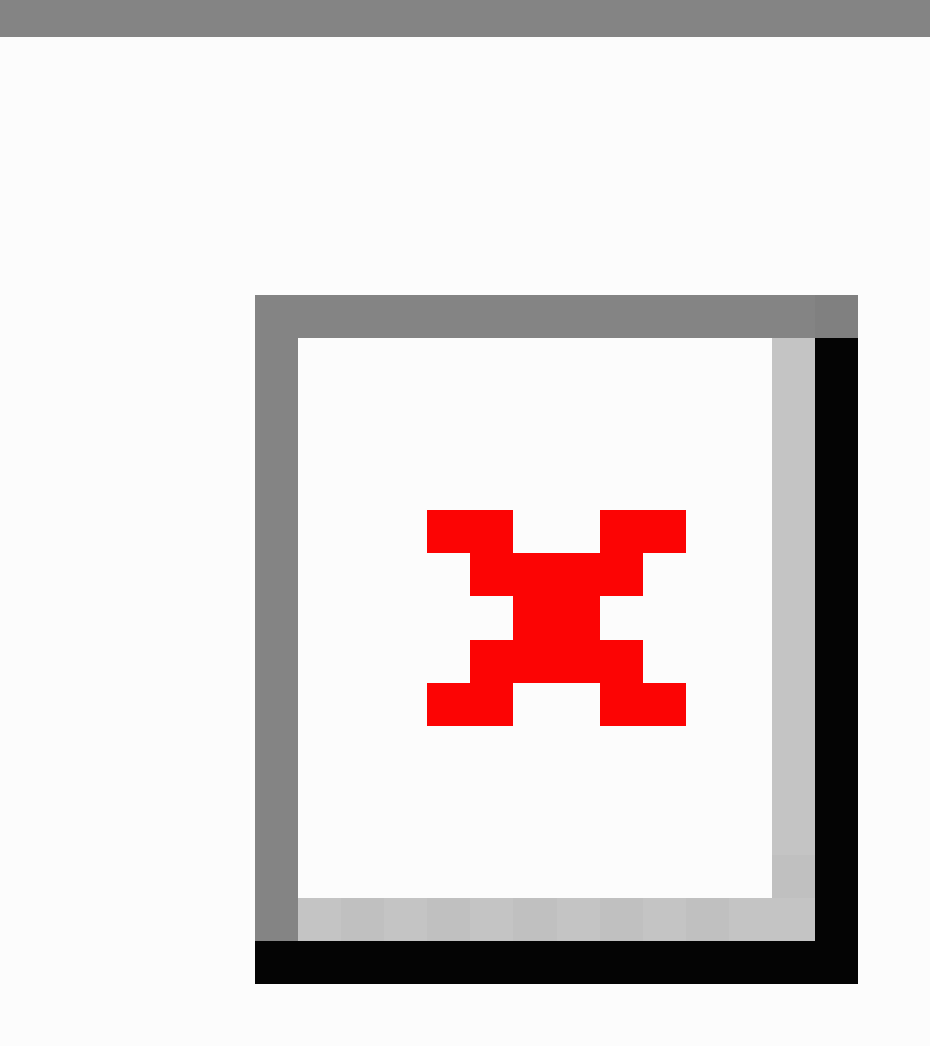
Figure 5. Collection of photos with job opportunities and information on social